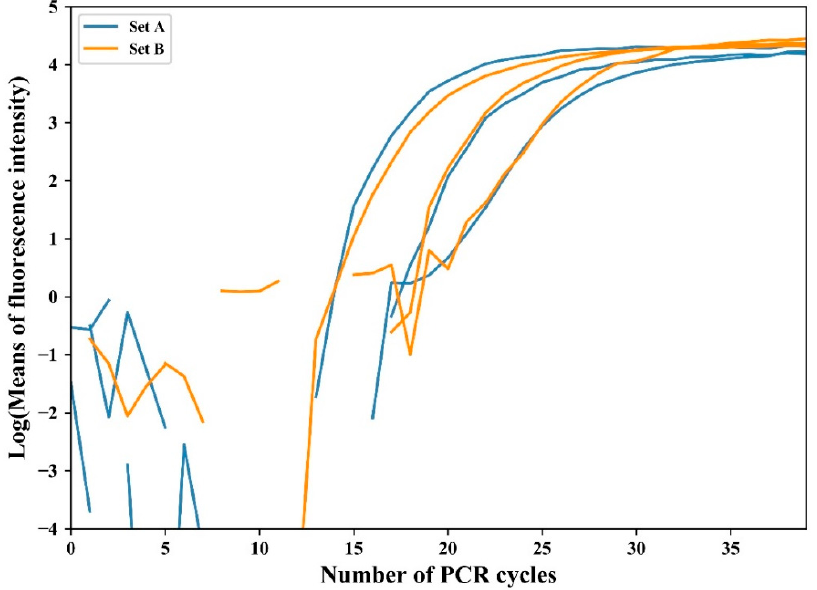
Figure 9. Distance distribution according to log threshold for each experiment set.